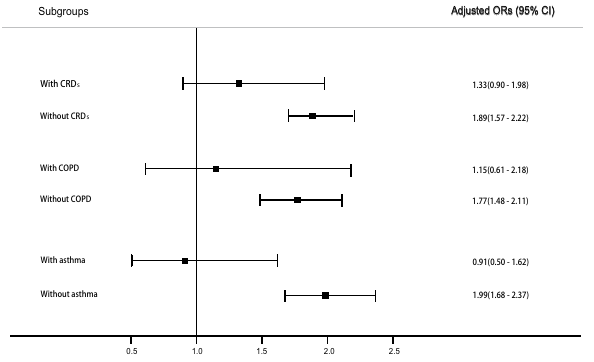
Figure 2. Association between post-extubation corticosteroid use and re-intubation rate in patients with different respiratory diseases. The p for interaction is 0.199, 0.155, and 0.029 in groups with/without CRDs, COPD, and asthma, respectively. COPD chronic obstructive pulmonary disease, CRDs chronic respiratory